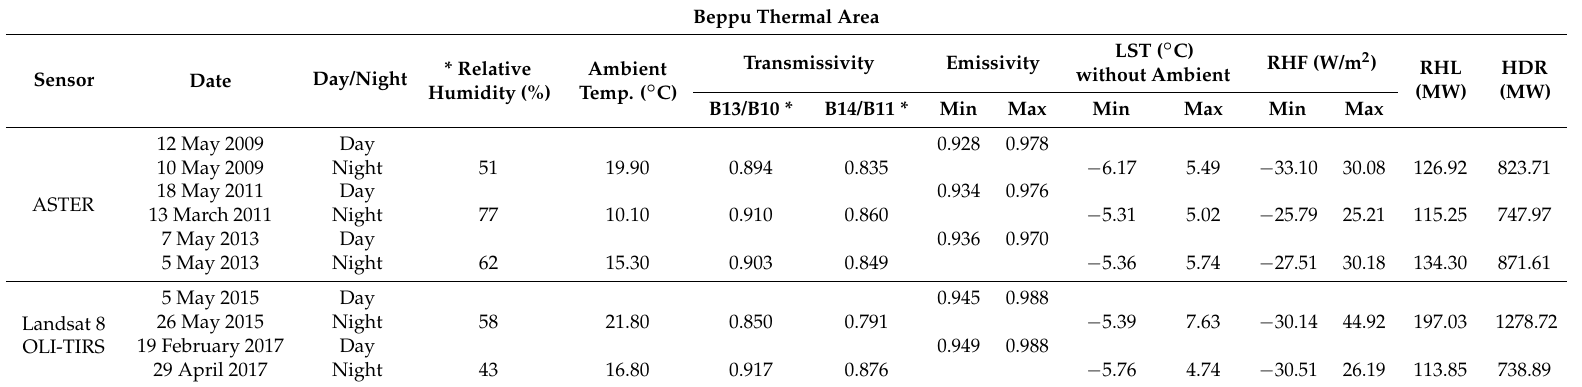
Table 4. Summary of heat loss in the Beppu geothermal area from 2009 to 2017 based on ASTER and Landsat 8 TIRS images. Ambient temperature and relative humidity were recorded at Oita station